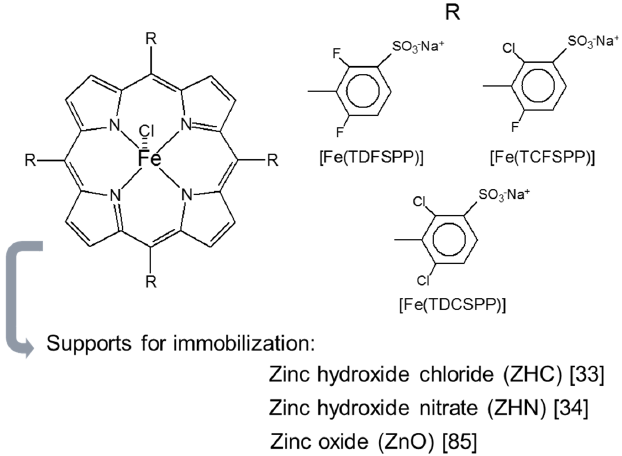
Figure 6. Structure of the anionic iron(III) porphyrins (FeP) employed in references [33,34,85]. [Fe(TDFSPP)Na 4 ]Cl = [tetrasodium-5,10,15,20-tetrakis(2,6-difluoro-3-sulfonatophenyl)porphyrinate iron(III)] chloride; [Fe(TCFSPP)Na 4 ]Cl = [tetrasodium-5,10,15,20-tetrakis (2-chloro-6-fluoro-3- sulfonatophenyl)porphyrinate iron(III)] chloride, and [Fe(TDCSPP)Na 4 ]Cl = [tetrasodium-5,10,15,20- tetrakis (2,6-dichloro-3-sulfonatophenyl) porphyrinate iron(III)] chloride. The same family of FePs (Figure 6) was also immobilized on layered zinc hydroxide chloride (ZHC) [33]. Replacing the exchangeable nitrate ion with the chloride ion grafted in the layer composition elicited a different catalytic activity. The FeP immobilization degree in LHSs changed (immobilization degree is the percentage of FeP immobilized on the solid support relative to the mass of FeP used during the immobilization procedure). For the same immobilization reaction conditions, the immobilization degree of the three FePs on ZHN was near 100% [34], whereas the immobilization degree was approximately 30% [33] in the ZHC support. This difference was attributed to non- effective coordination of nitrate to the ZHN layers [43]. The anionic FeP substituted the free nitrate ion located between the layers and on the ZHN solid surface [34,79]. In the case of the ZHC support, the chloride ions were directly coordinated to the layers [43] and could not be exchanged with the anionic complex. This left only the positive charges on the crystal edges to interact with the FePs [33]. FeP immobilization on different LHS sites directly influenced the oxidation catalysis results. Catalysts immobilized on ZHN and ZHC were selective for cyclohexanone and cyclohexanol during cyclohexane oxidation, respectively [33], which meant that the reaction followed the classic route expected for FePs in solution in the latter case [10,17,82]. Indeed, FeTDCSPP-ZHC (FeDC-ZHC) afforded 23% cyclohexanol and 2% cyclohexanone yields [33] vs. 70% cyclohexanone and 2% cyclohexanol achieved in the presence of FeTDCSPP-ZHN in the same reaction conditions. The reaction conducted in the presence of the FeP immobilized on ZHN followed a radical mechanism,